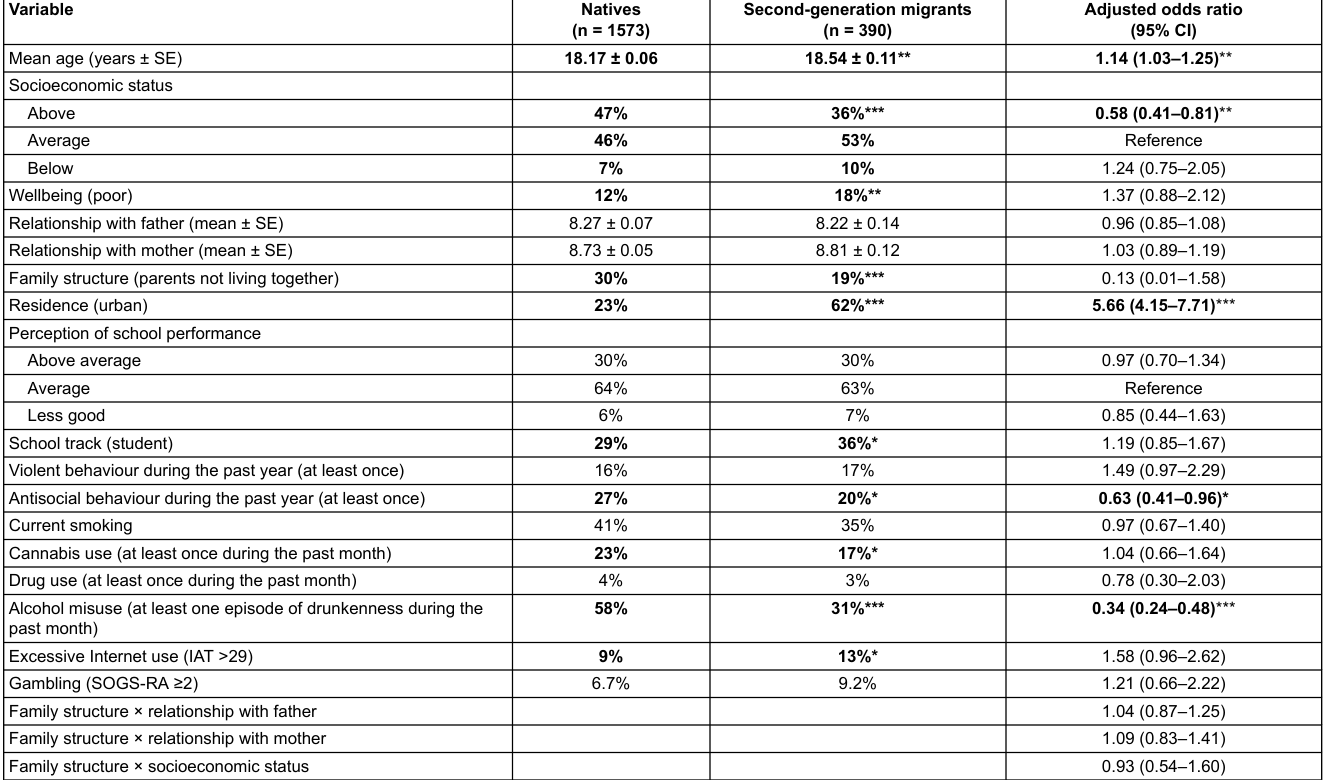
Table 2: Boys: comparison of second-generation migrants vs natives in the age group 15–24 years in post-mandatory schools.